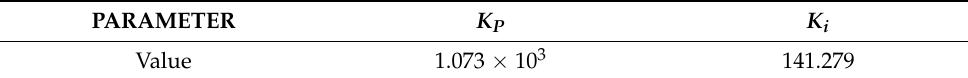
Table 3. Optimized parameters of PI controller based on